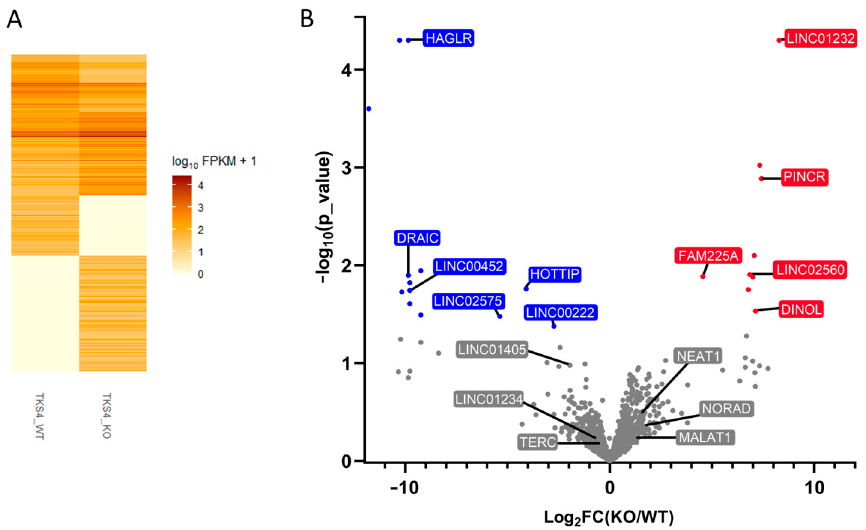
Figure 5. Changes in lncRNA expression in Tks4 KO cells. ( A ) Heat map of the lncRNA expression levels in the Tks4 KO and the wild-type HCT116 cells. Each band corresponds to a specific gene. Darker colors represent higher expression levels. ( B ) Volcano plot of the differentially expressed lncRNAs in Tks4 KO cells. Each dot represents a specific gene. Gray: non-significant changes, red: upregulation, blue: downregulation.